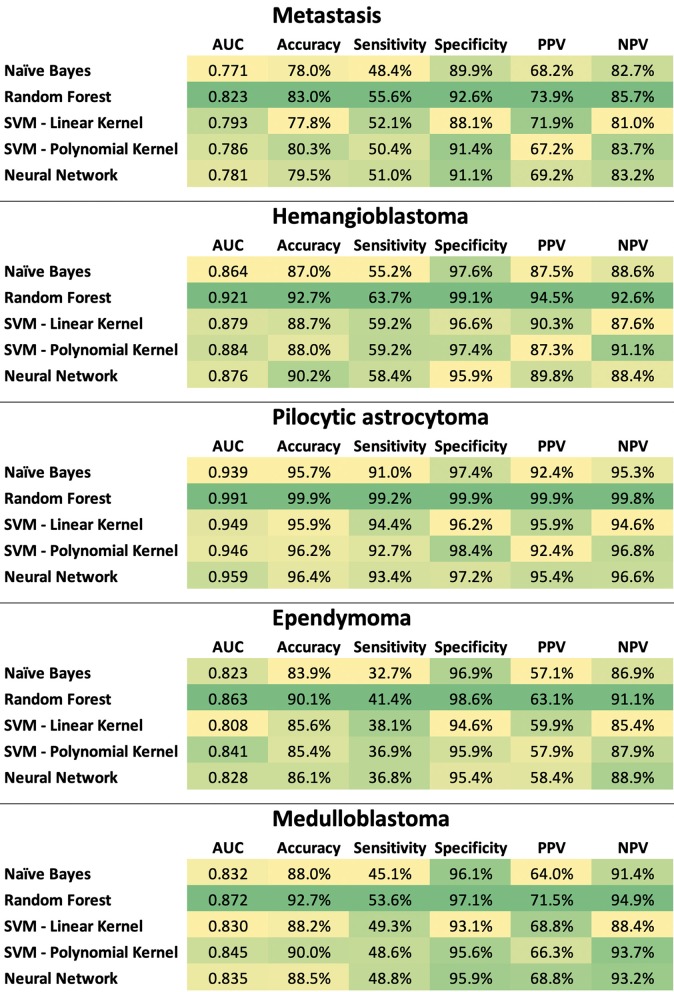
Heat map summary for classification performance of different machine learning algorithms in dichotomized differentiation of the 5 most common posterior fossa tumors. The test characteristics were calculated in validation datasets from ×100 repeats of 5-fold cross validation– details in Supplemental Tables 2, 3. NPV, negative predictive value; PPV, positive predictive value; SVM, support vector machine.